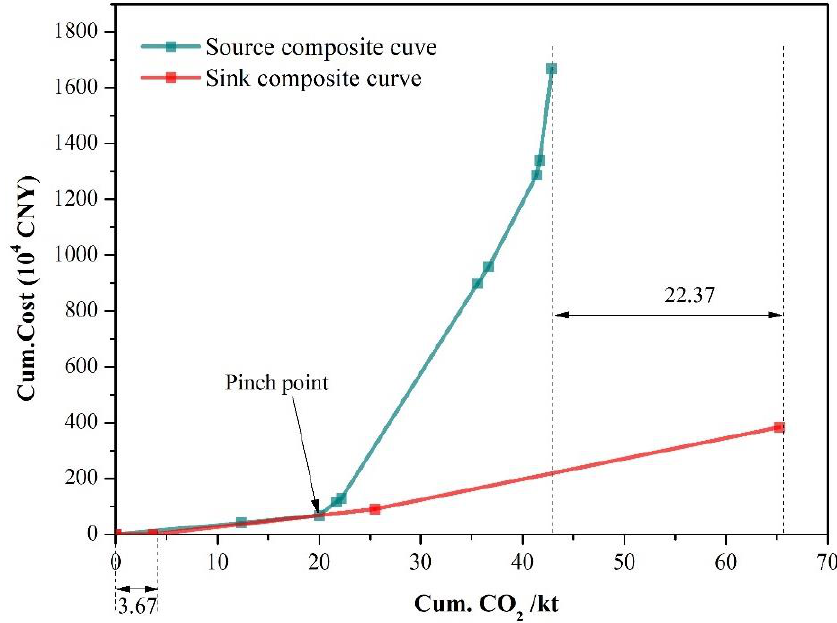
Figure 6. Optimized composite curve of the tobacco industry for Scenario 2.